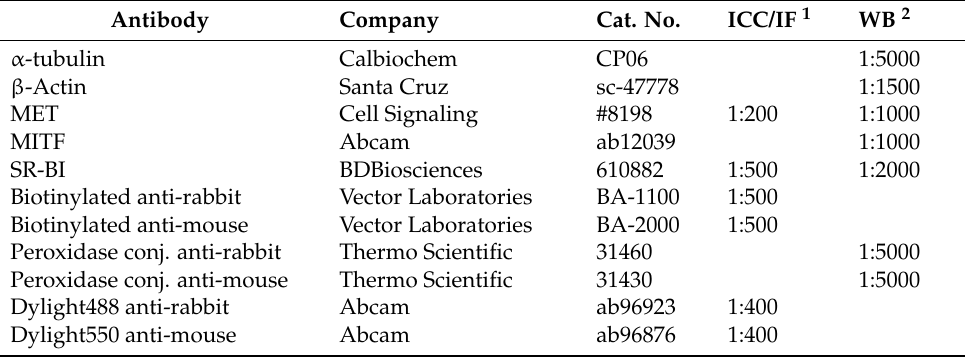
Table 2. Table of